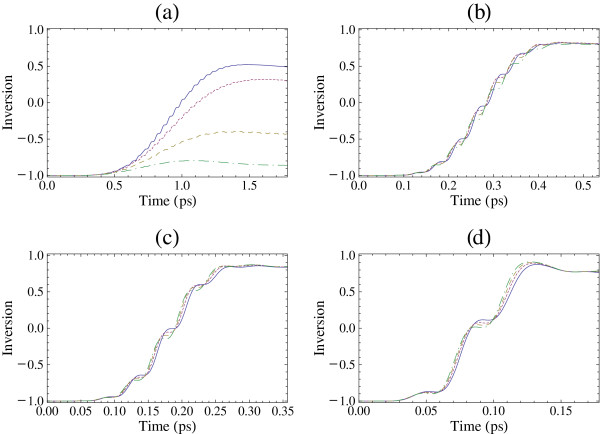
The time evolution of the inversion S3(t) for a sin-squared pulse. The excitation is on-resonance, i.e., ω = ω10, the pulse area is θ = Π, and φ= 0. (a) np= 10, (b) np= 3, (c) np= 2, and (d) np= 1. Solid curve: N = 109cm−2, dotted curve: N = 3 × 1011cm−2, dashed curve: N = 5 × 1011cm−2, and dot-dashed curve: N = 7 × 1011cm−2.